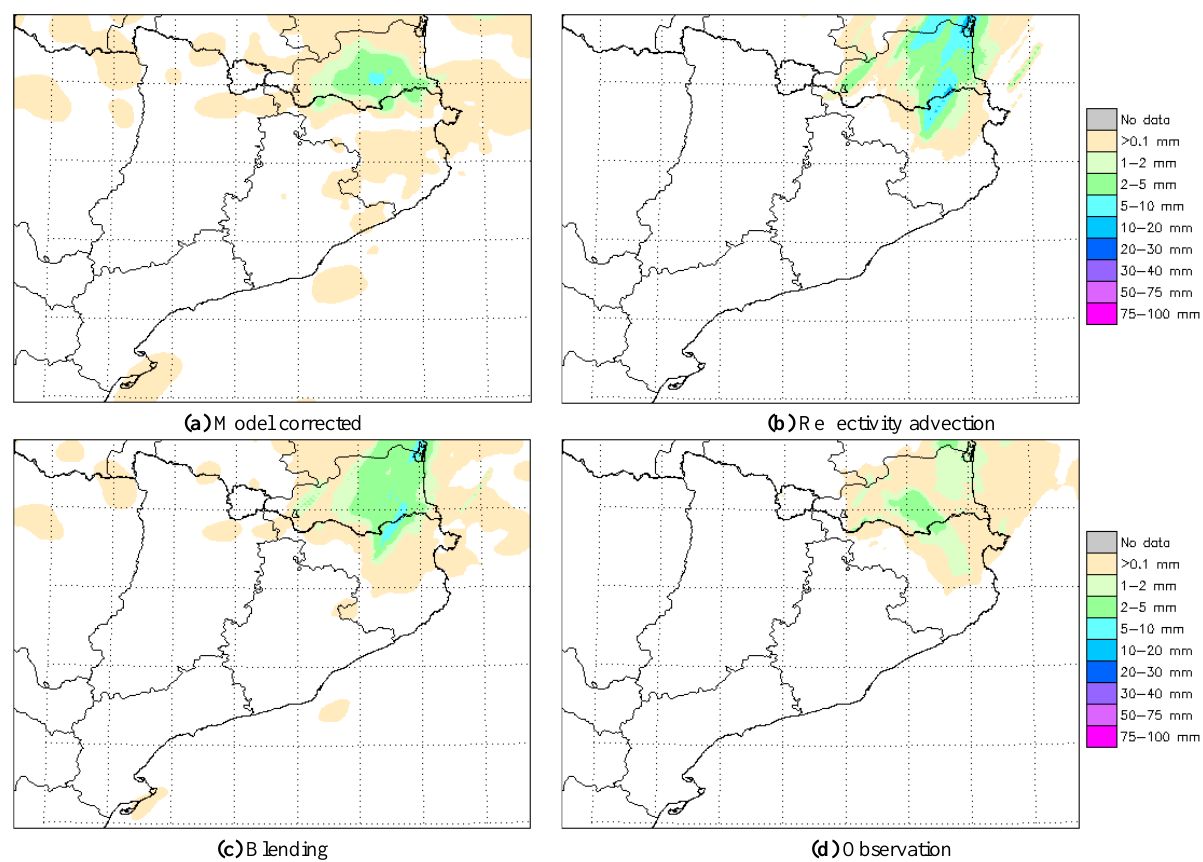
Fig. 6. An example of 22:00UTC blending forecast for the second hour (00:00UTC) of the 14 July 2009 event.